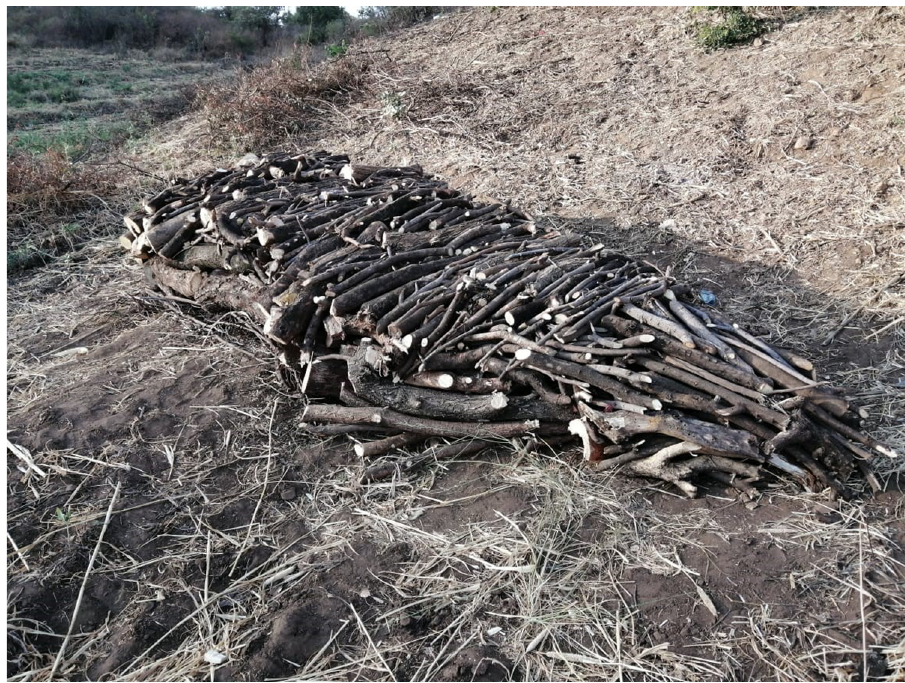
Figure 6: Charcoal burning in Tharaka Nithi County. While tree felling is outlawed in many counties, inadequate oversight and enforcement still allow such land degrading practices to